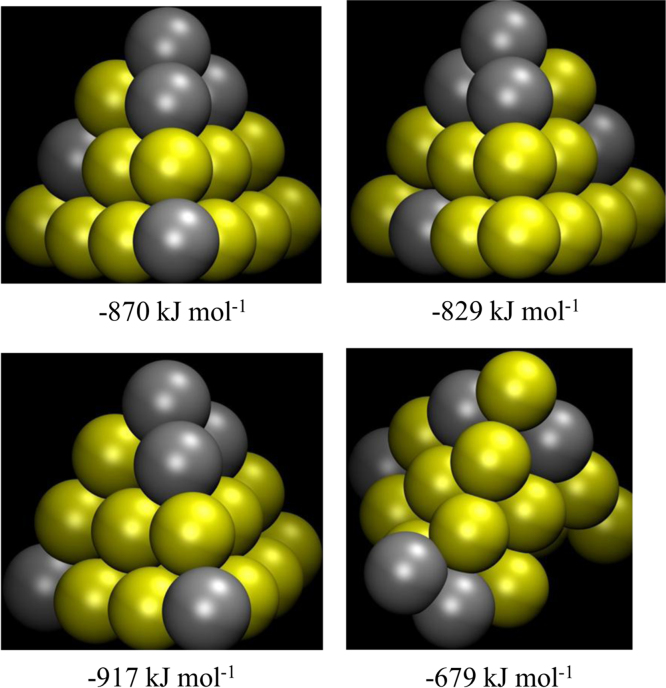
Representative stable structures of Au15Ag5 and corresponding formation energies.